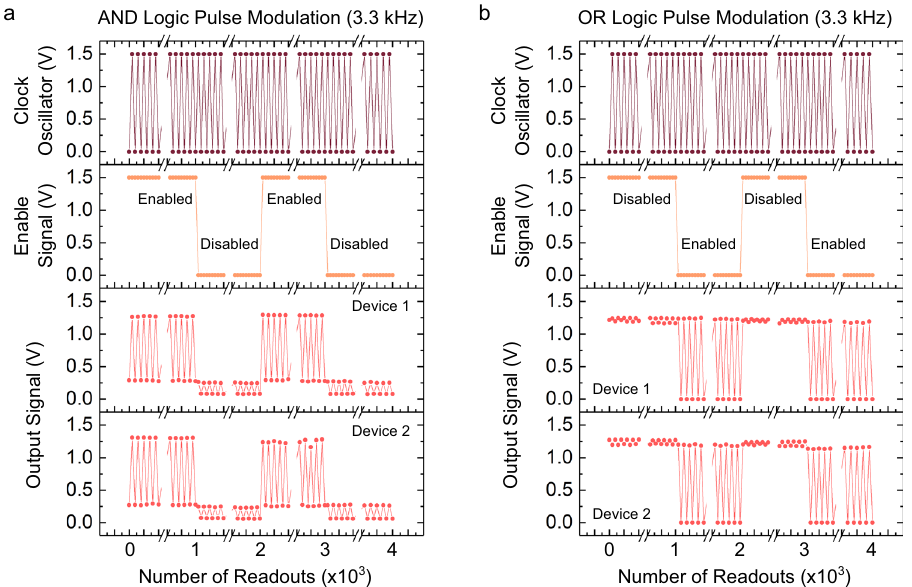
Fig. 6 Fast pulse modulations on logic circuits comprising Au mica /PCBA//PSI//EGaIn junctions and Au mica /PCBM//PSI//EGaIn junctions and printed EGaIn electrodes. a Operations of pulse modulation achieved by two AND logic circuits at a frequency of 3.3 kHz. b Operations of pulse modulation achieved by two OR logic circuits at a frequency of 3.3 kHz. Here, the clock oscillator generates a rectangular pulse of 1.5 V at a frequency of 3.3 kHz, the enable signal is switched between 1.5 V and 0 V to modulate the output of the circuit. Note that the connecting lines between data points do not correspond to the actual